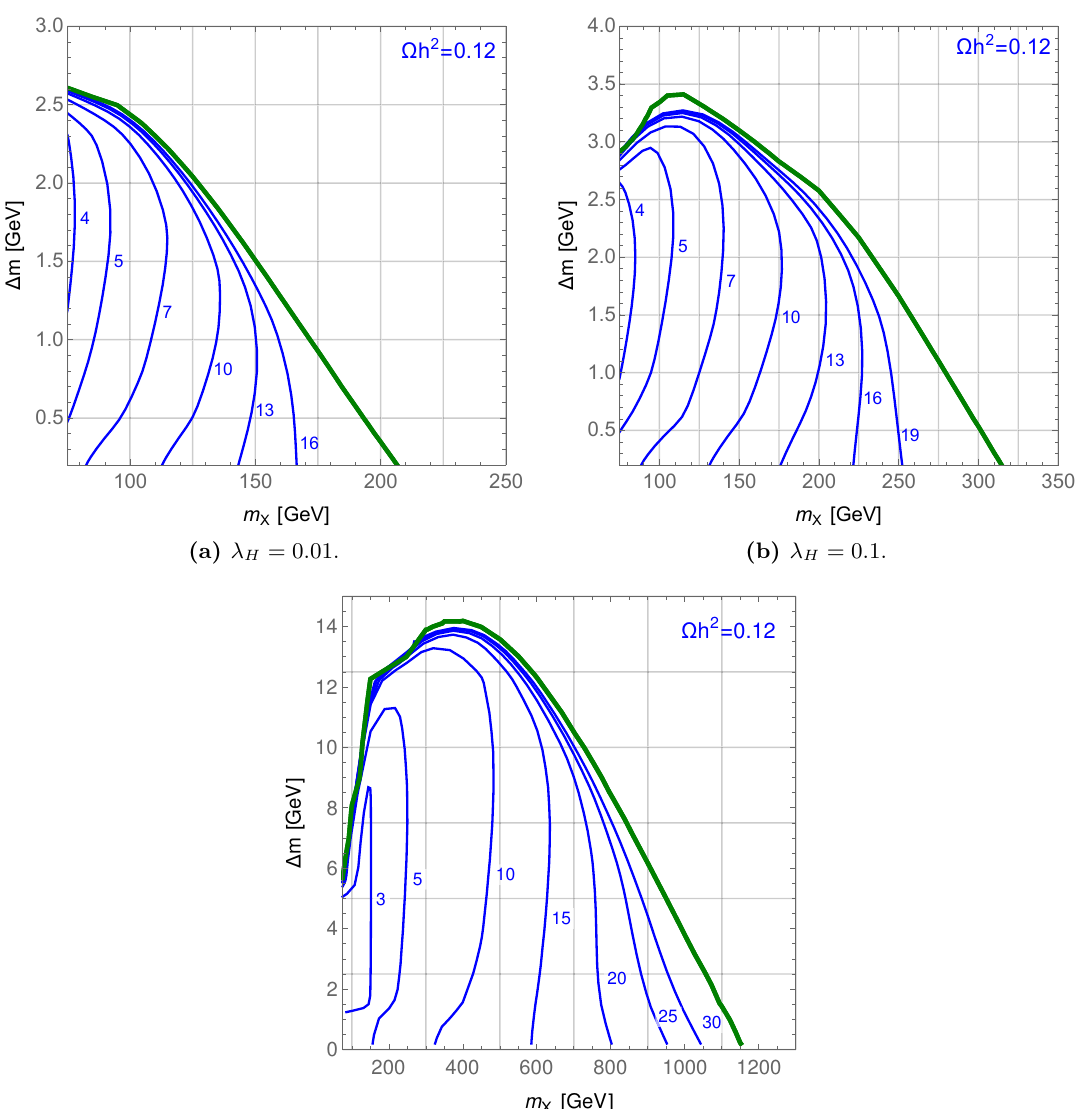
Figure 5 . Viable parameter space for DM abundance through conversion driven freeze-out for several value of the H φ coupling λ H . Contours denoting Ω h 2 = 0 . 12 for fixed value of the Yukawa − 7 are shown with blue lines. The border of the parameter space is delimited by 10 coupling λ − χ / a green contour corresponding the combinations of ∆ m, m giving rise to the right dark matter abundance through mediator annihilation driven